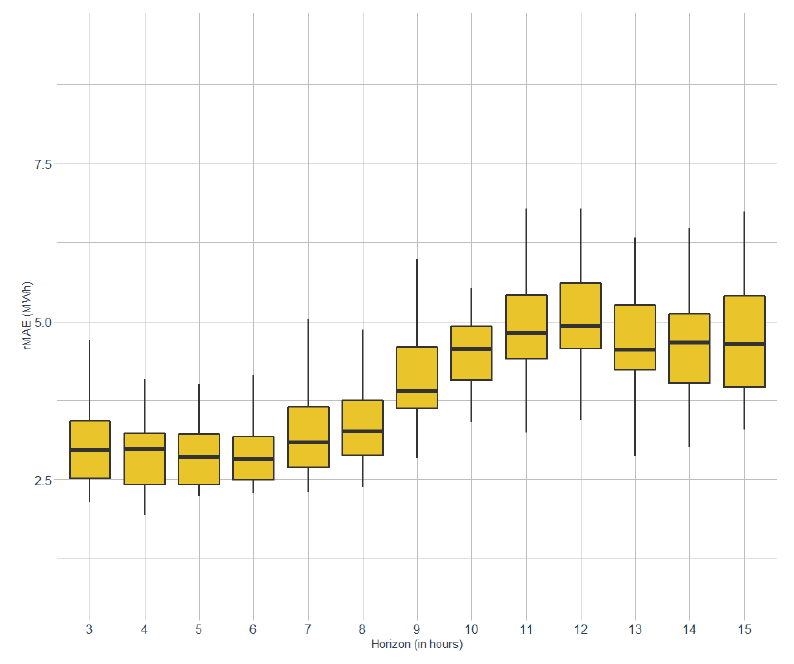
Figure 5. RMAE distribution by horizon for Intraday 6.